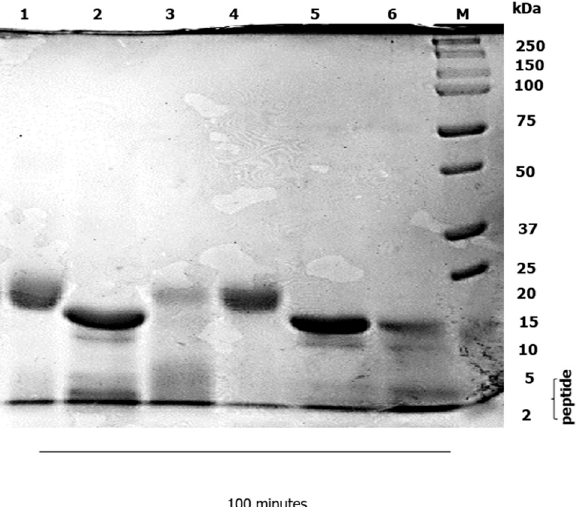
Figure 4. SDS–PAGE showed in vitro infant digestion of conjugated protein, using pancreatin and without pancreatin. The β -Lg was digested within 60 min (Lane 5), and after 100 min (Lane 6) there was no remaining β -Lg intact. Lane 1 represents WPI–Lac without pancreatin; Lane 2 represents 0 min; Lane 3 represents 5 min; Lane 4 represents 30 min; Lane 5 represents 60 min; and Lane 6 represents 100 min. Lane M represents the protein marker.